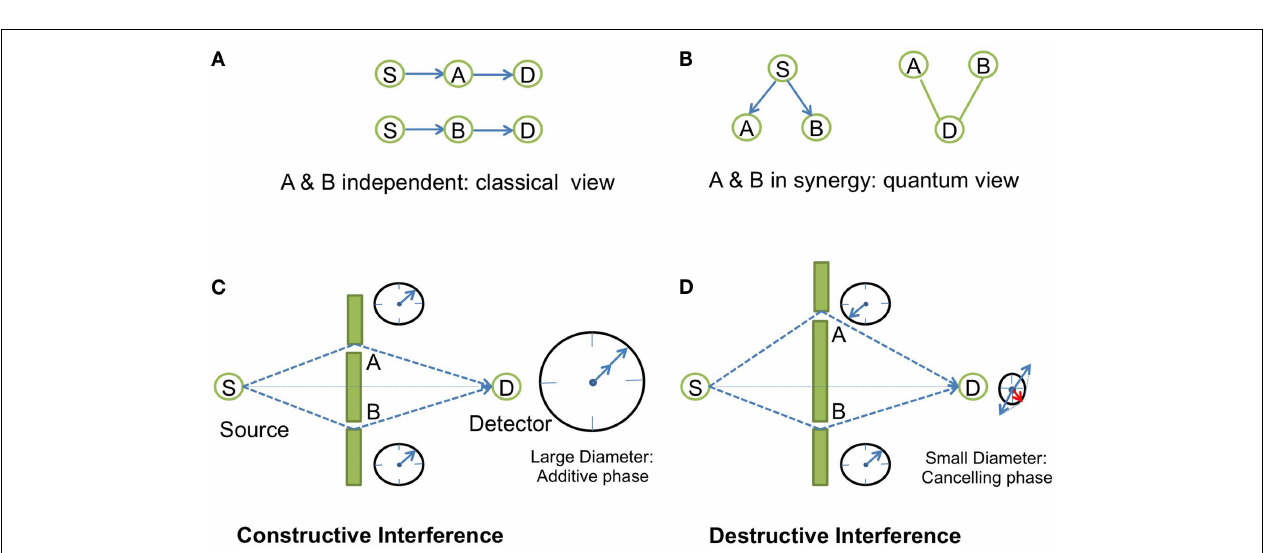
FIGURE 1 | Synergistic effects inYoung’s interference experiment . In Young’s experiment, a source S sends photons to a detector D that is located behind a wall with two tiny slots A and B on each side of the line between S and D . (A) When the two slots A and B are independent (by disconnecting the entanglement in measuring the photons emerging from one slot with a detector behind A or B ), there is no interference, and the distribution of photons on the z -direction of the screen is just Gaussian. This is the classical view of the experiment. (B) In quantum view, using amplitude of probability, the photon emerging from S and going to D has two alternating ways: slot A or slot B .The probability of the total event is the square of the amplitude of probability given by the sum of the two amplitudes for each alternating event Prob ( S – D ) = | (cid:104) S – A – D (cid:105)+(cid:104) S − B − D (cid:105) | 2 ,